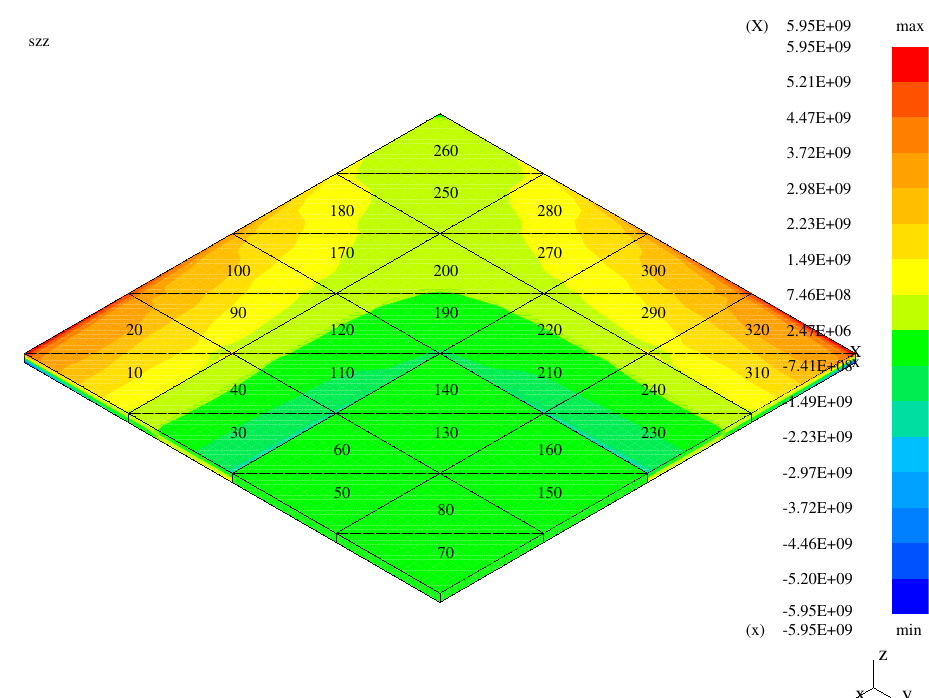
Figure 11. Transverse stress—the bent plate with the classical transition